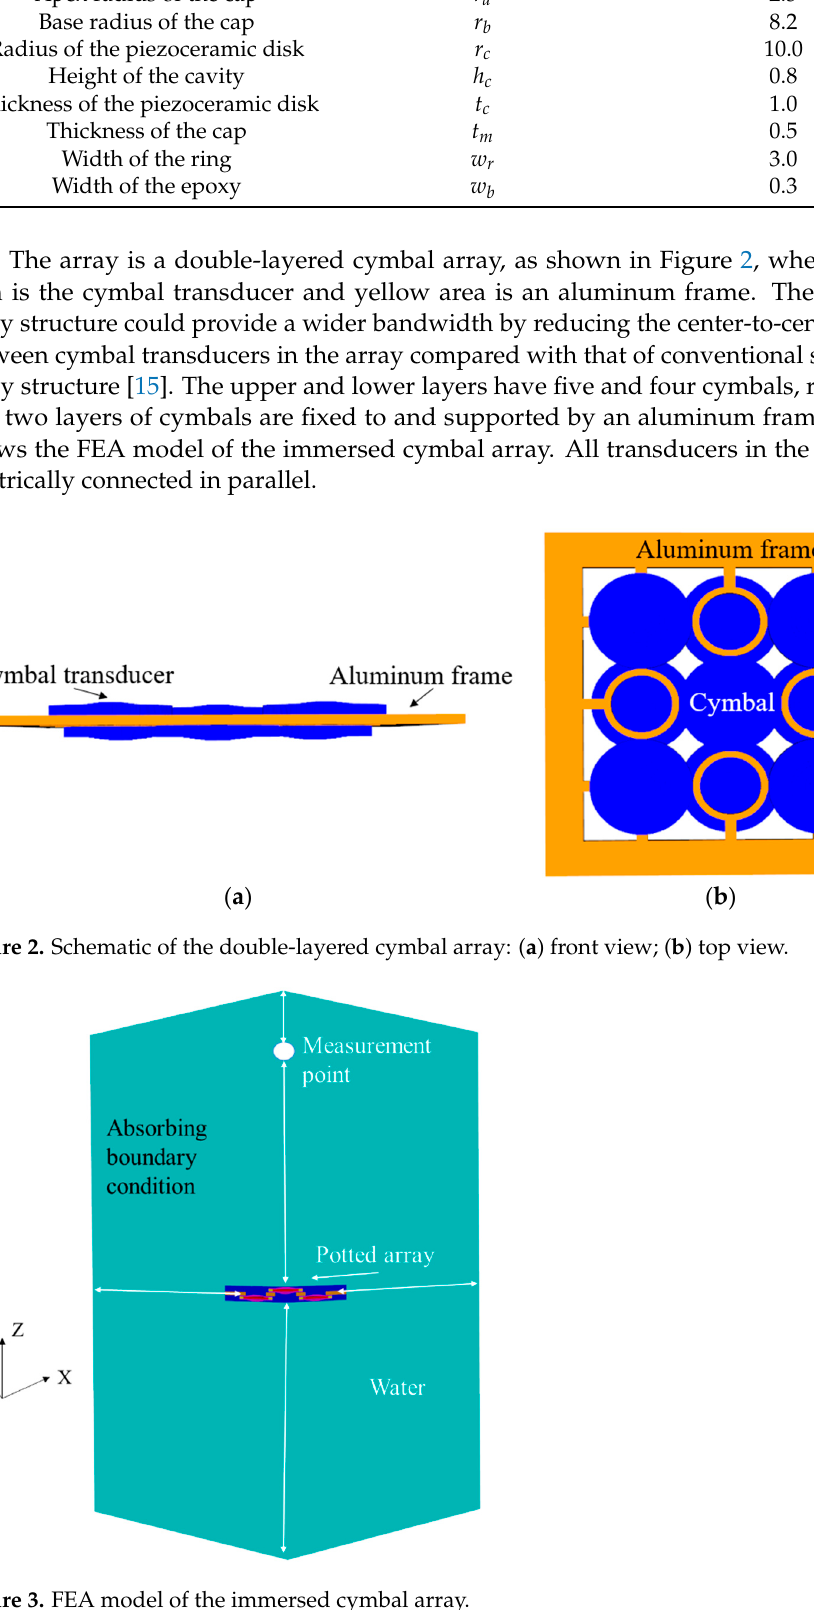
Table 1. Structural parameters and dimensions of the cymbal transducer.